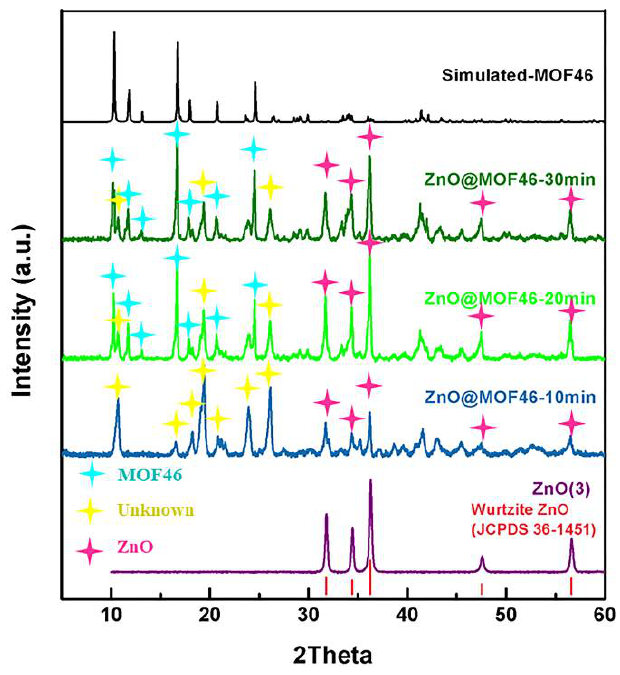
Figure 7. XRD patterns of ZnO@MOF-46(Zn) sonicated for 10, 20, and 30 min.